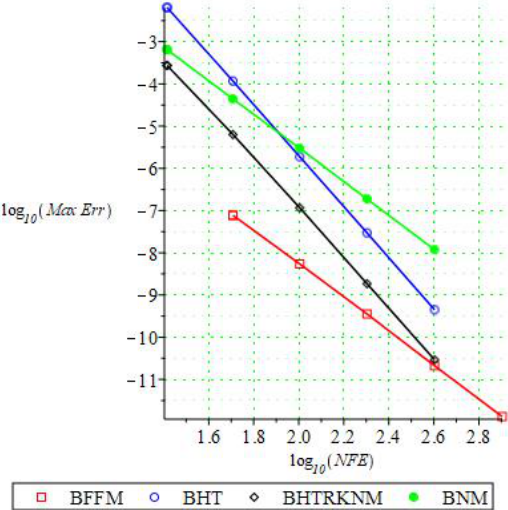
Figure 3. Efficiency Curves for Example 1.